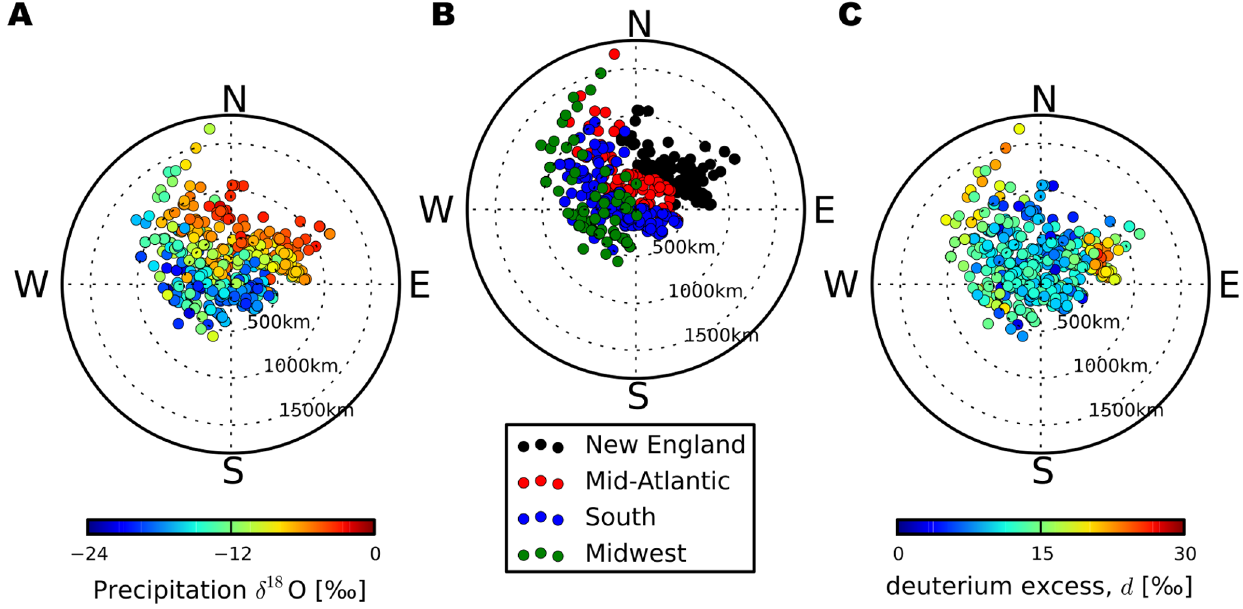
Figure 3. Sandy precipitation isotopic composition relative to storm center. Precipitation ( A ) d 18 O and ( C ) deuterium-excess with data points positioned relative to the storm center at time of sample collection. ( B ) Samples are grouped by region as in Figure 1.